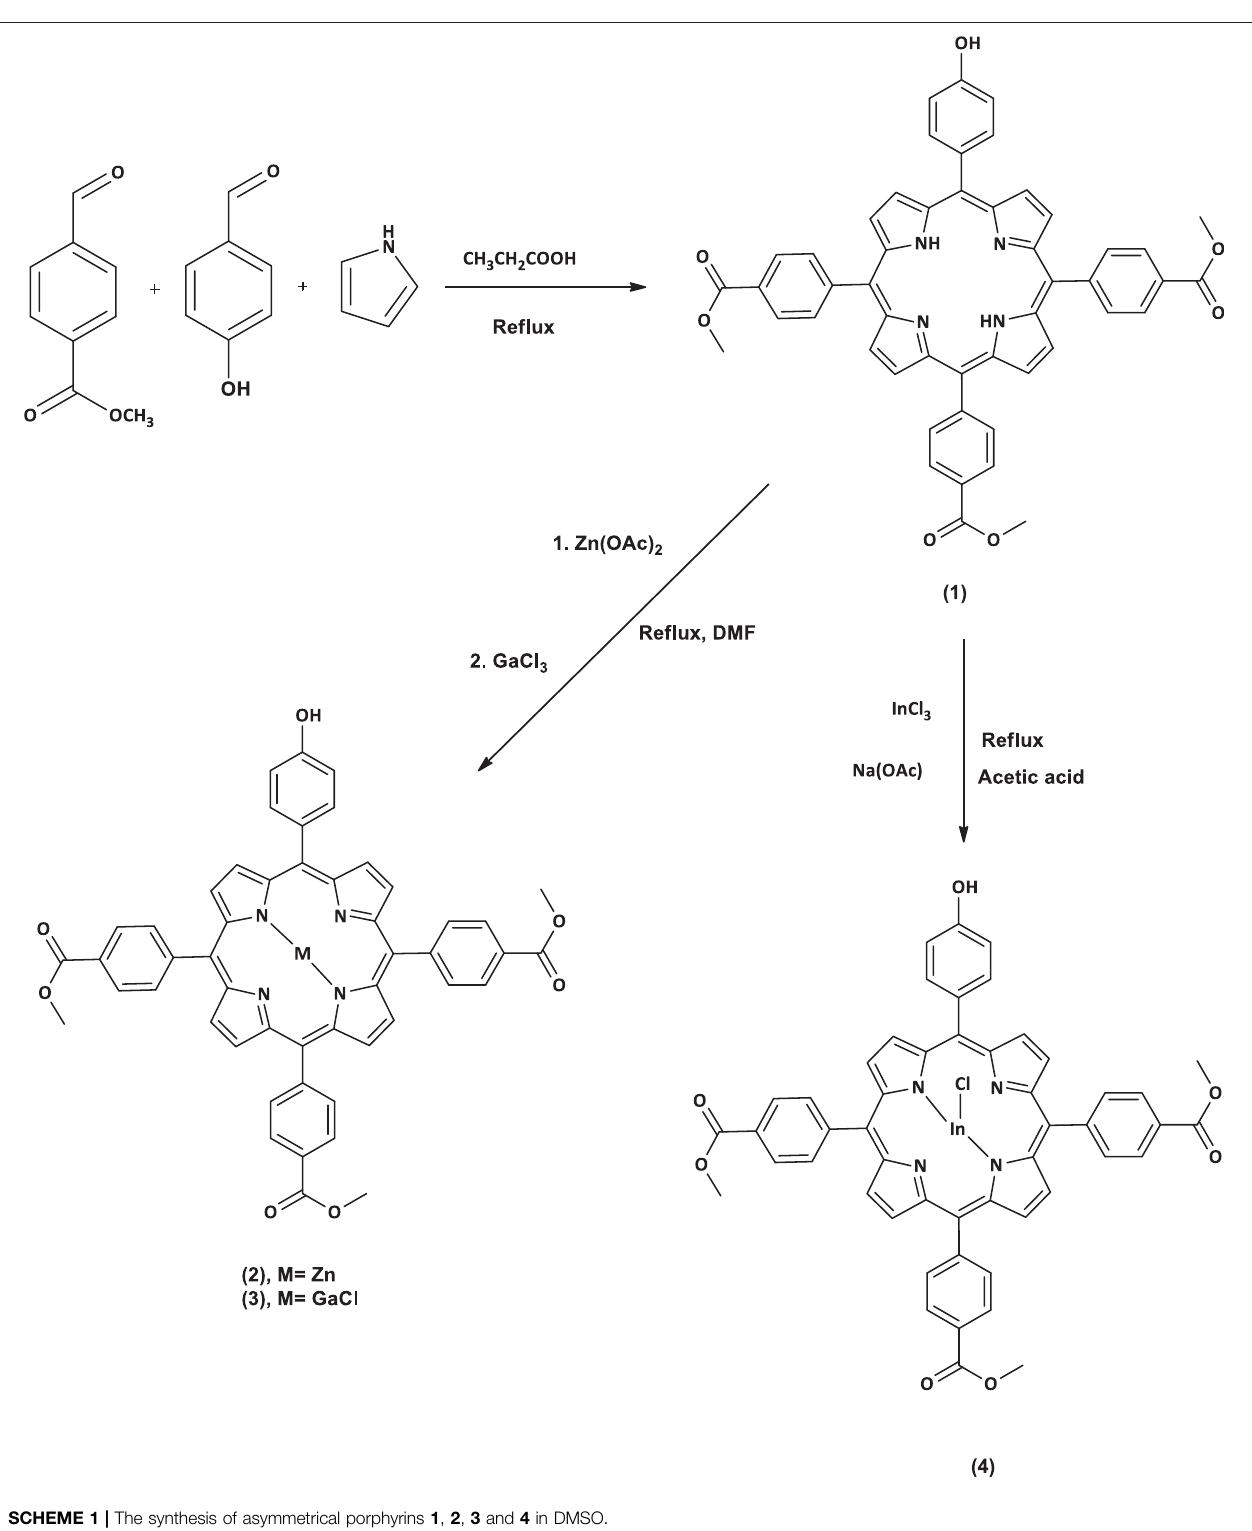
SCHEME 1 | The synthesis of asymmetrical porphyrins 1 , 2 , 3 and 4 in DMSO.